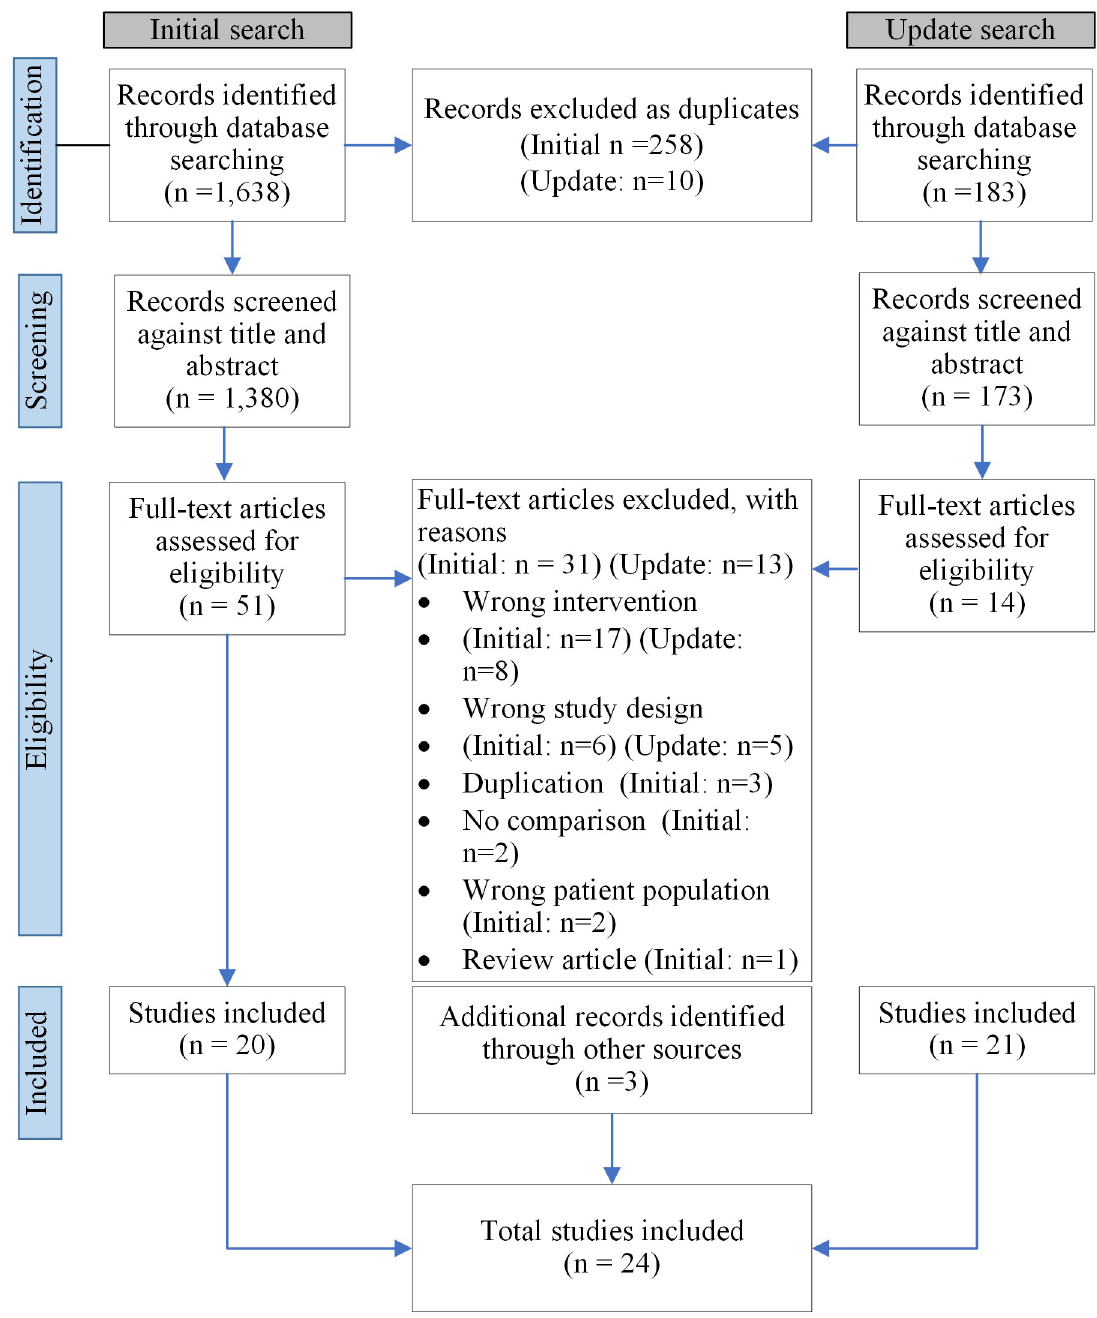
Fig 1. A PRISMA flow chart of studies included and excluded at each